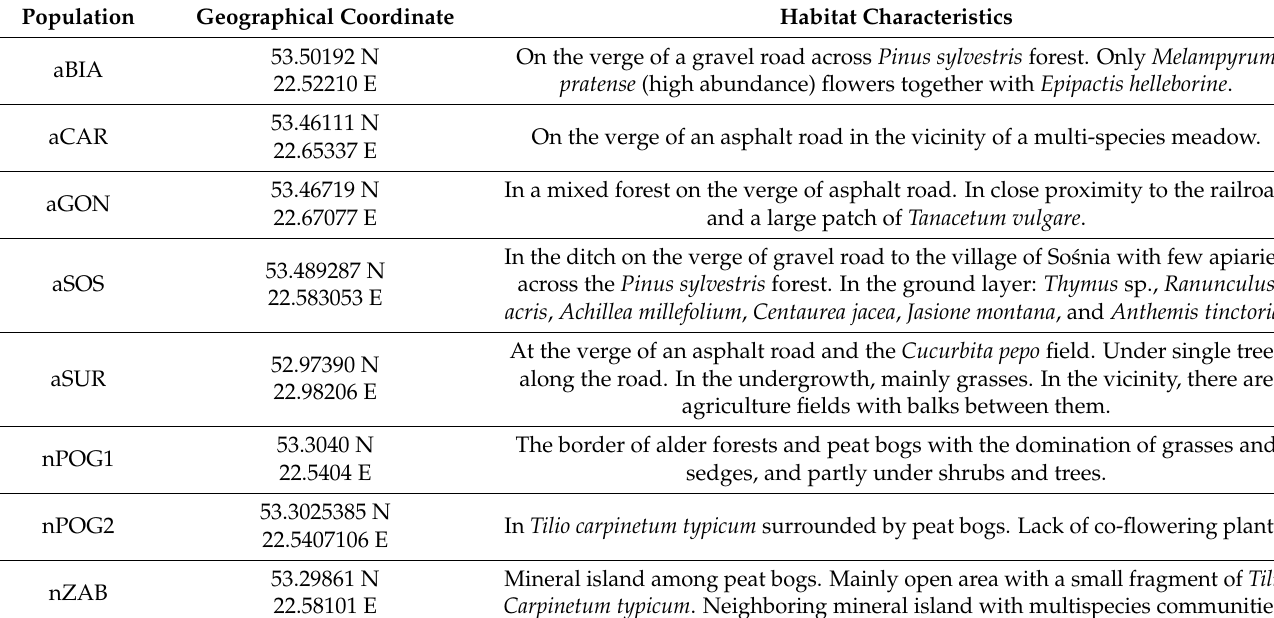
Table 7. Characteristics of habitats with Epipactis helleborine